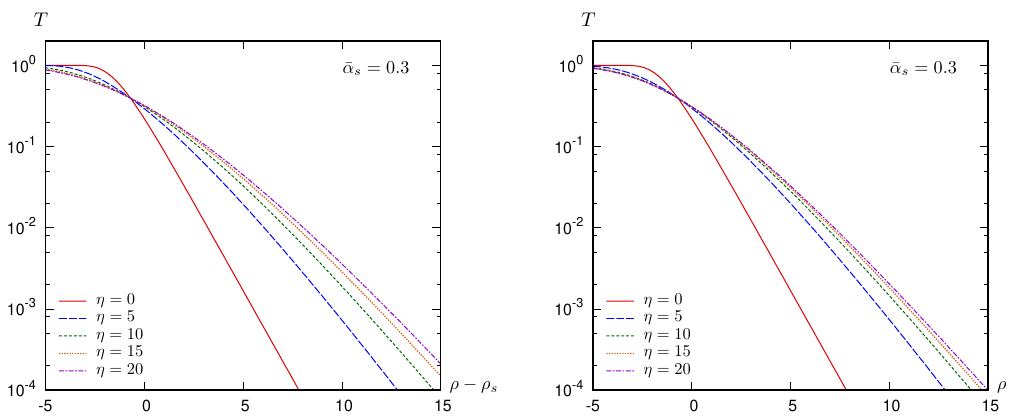
Figure 8 . Left: the amplitude obtained from the non-local equation (6.1) plotted as a function of the scaling variable (cid:26) (cid:26) s . Right: the same for the amplitude obtained by solving LO BK. In both (cid:0) cases the amplitude exhibits geometric scaling. The non-local equation leads to a front which is a bit less